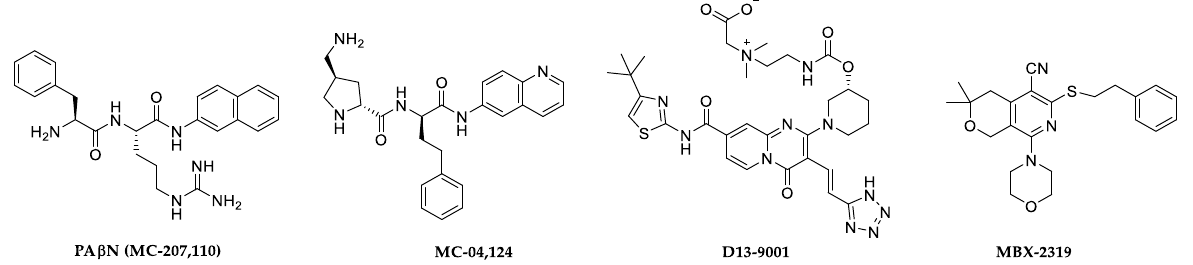
Figure 1. Chemical structures of representative lead efflux pump